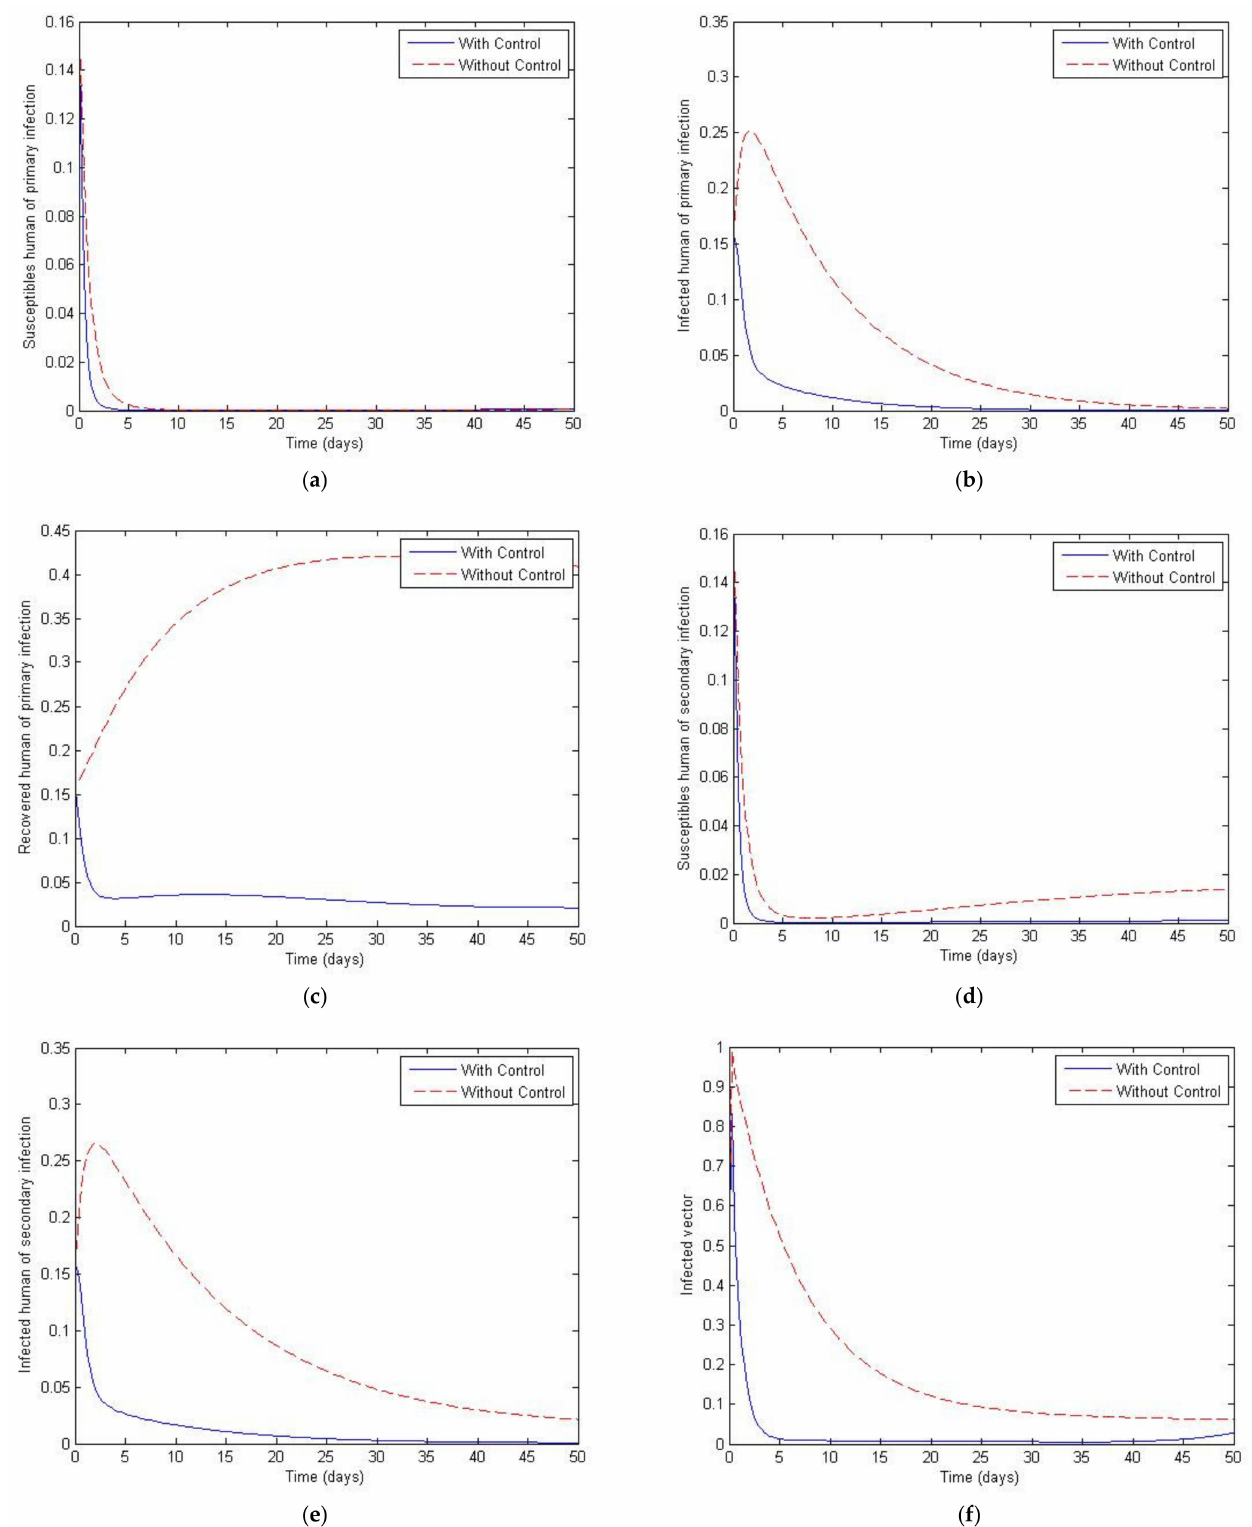
Figure 17. Simulation results of system of Equations (38)–(43) with and without controls of S HP , I HP , R HP , S HS , I HS and I V with X 1 = 100, X 2 = 100, N H = 500,000, N V = 100,000 . ( a ) Susceptibles of primary infection ( b ) Infected population with primary infection ( c ) Recovered human of primary infection ( d ) Susceptibles of secondary infection ( e ) Infected human of secondary infection (f) Infected